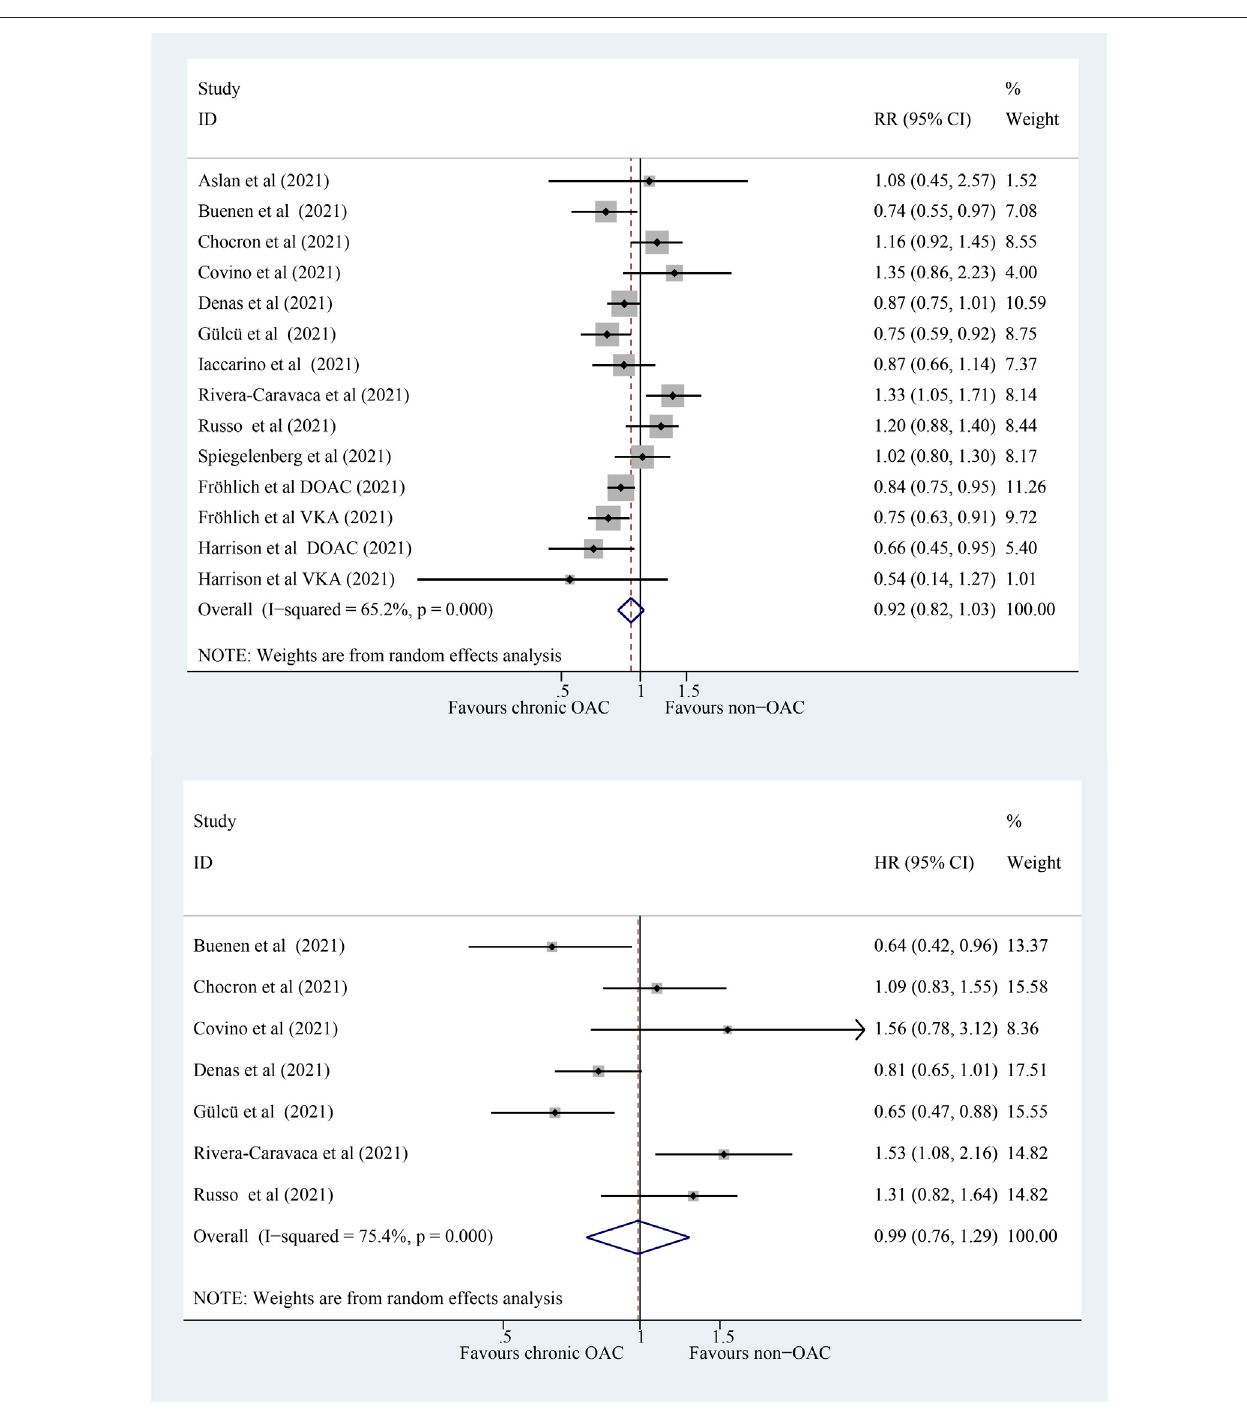
FIGURE 2 | Forest plot for association of chronic OAC with all-cause mortality in COVID-19 patients, random model. (A) Pooled the RR. (B) Pooled the adjusted HR. OAC, oral anticoagulation; COVID-19, coronavirus disease 2019; RR, relative risk; HR, hazard ratio; CI, con fi dence interval; DOAC, direct oral anticoagulant; VKA, vitamin K antagonist; P , heterogeneity